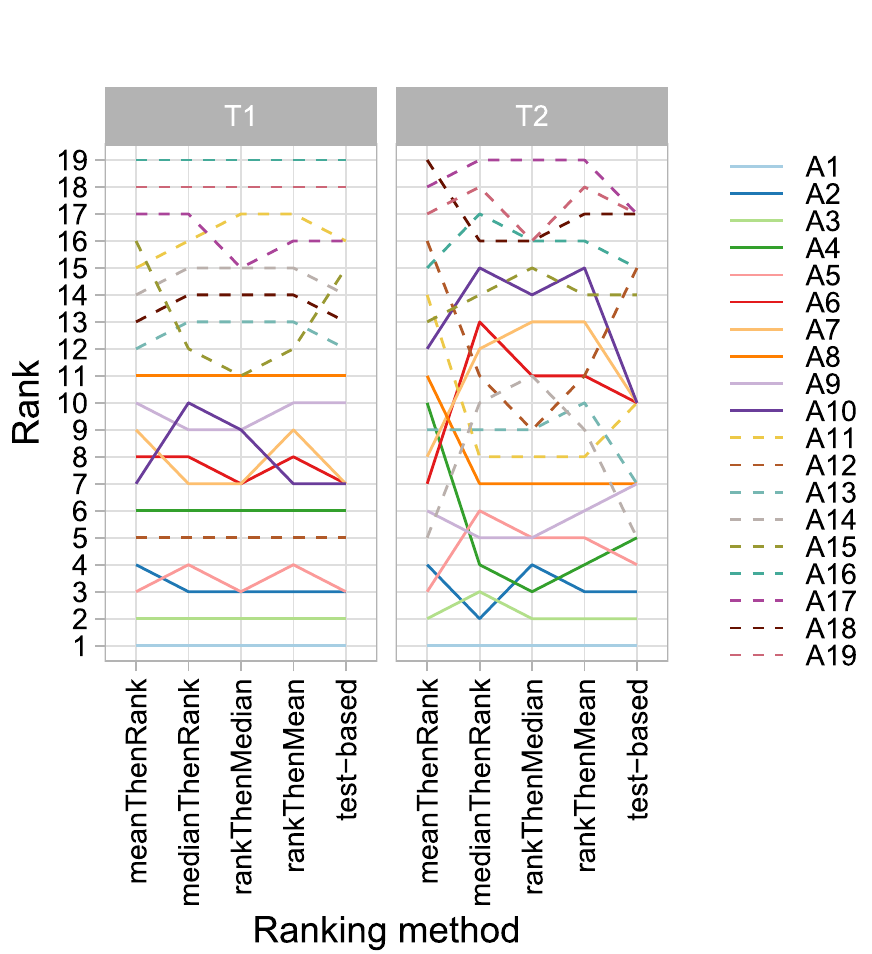
Figure 15. Line plots for visualizing rankings robustness across different ranking